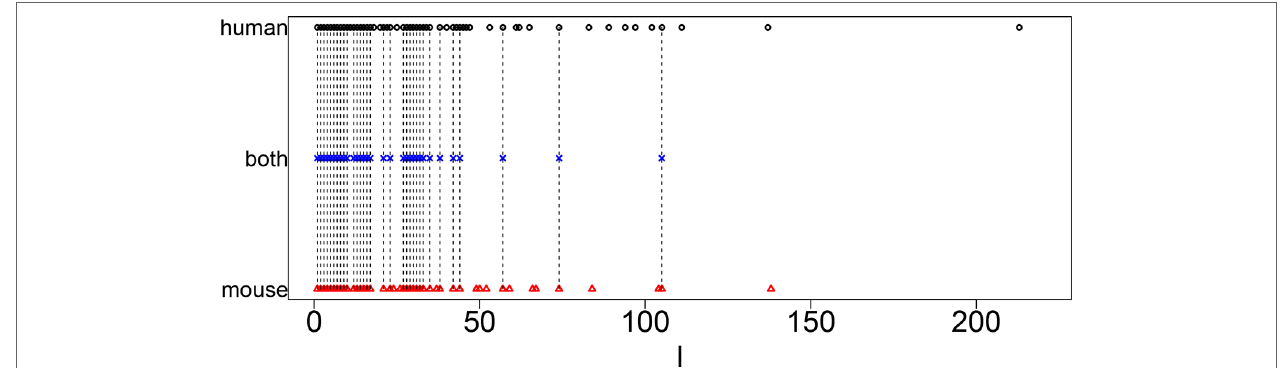
FIGURE 1 | Coincidence between singular value vectors shown in Table 2 . Horizontal axis: singular value vector numbering ℓ . Black open circles, ℓ selected for human; blue crosses, ℓ selected for both human and mouse; red open triangles, ℓ selected for mouse. Vertical black broken lines connect ℓ selected for both human and mouse.